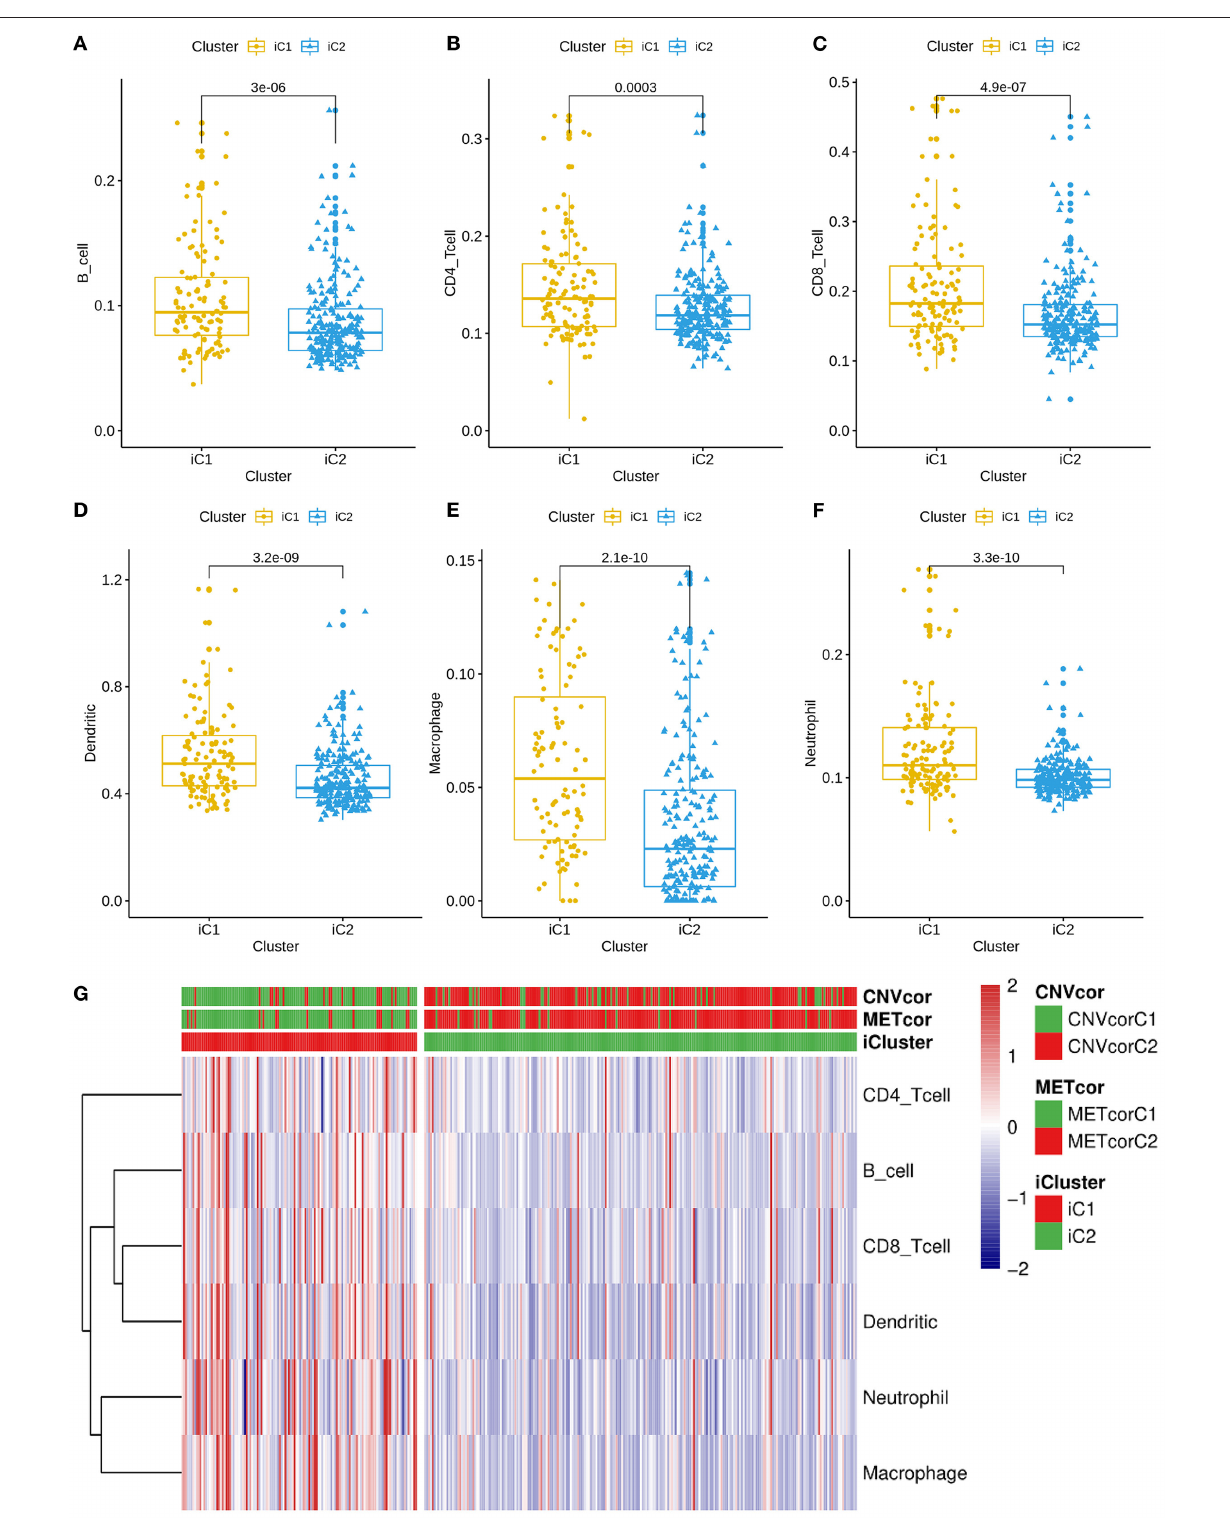
Frontiers in Medicine |